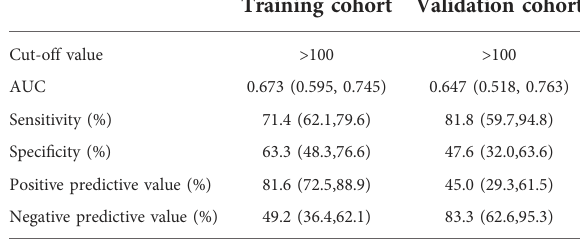
TABLE 4 Multivariate regression analysis in the validation